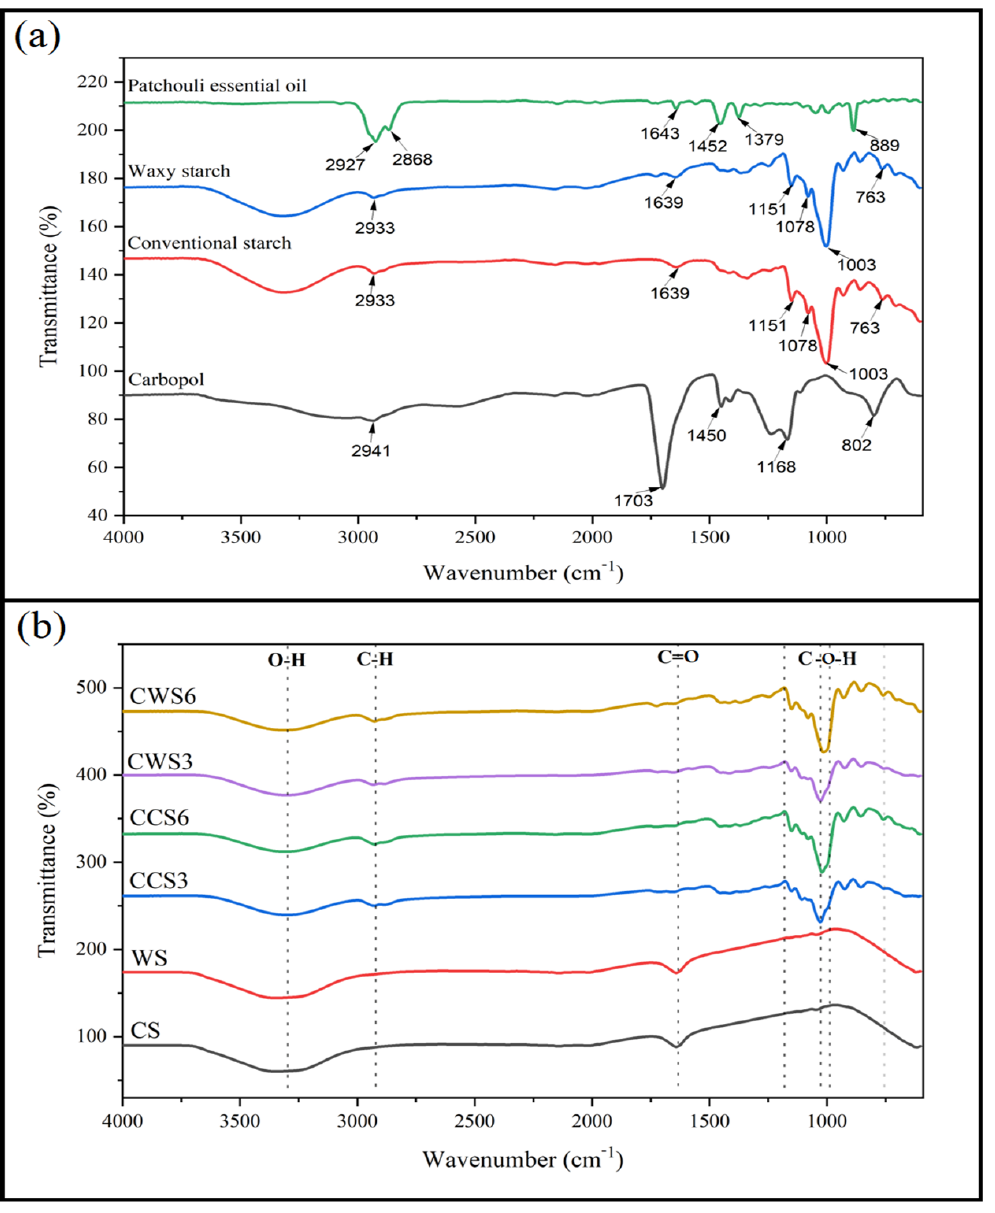
Figure 4. FT-IR spectra of the precursor materials ( a ) and the prepared hydrogel samples ( b ) at a wave number range from 4000 to 500 cm −1 .